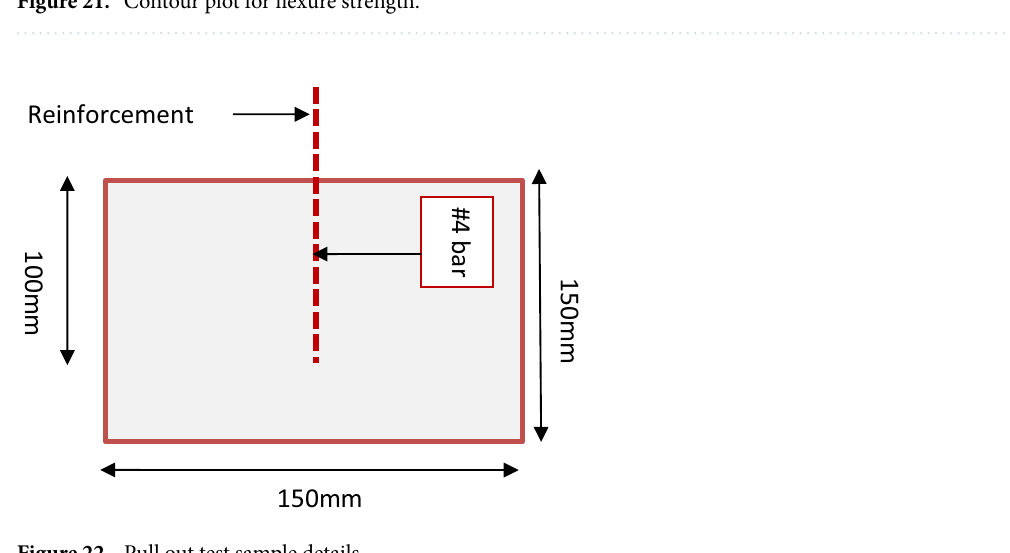
Figure 22. Pull out test sample